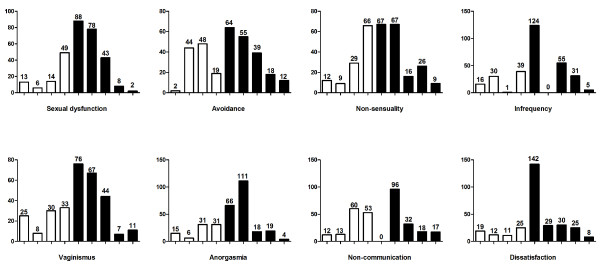
Participants' sexual function scores for each GRISS subscale (n = 301). Each graph shows the distribution of scores (from 1 to 9 on the x-axis) for each GRISS subscale, with the number of women (y-axis) above each score. Normal scores are 1 to 4 (clear columns) and abnormal scores are 5 to 9 (black columns).